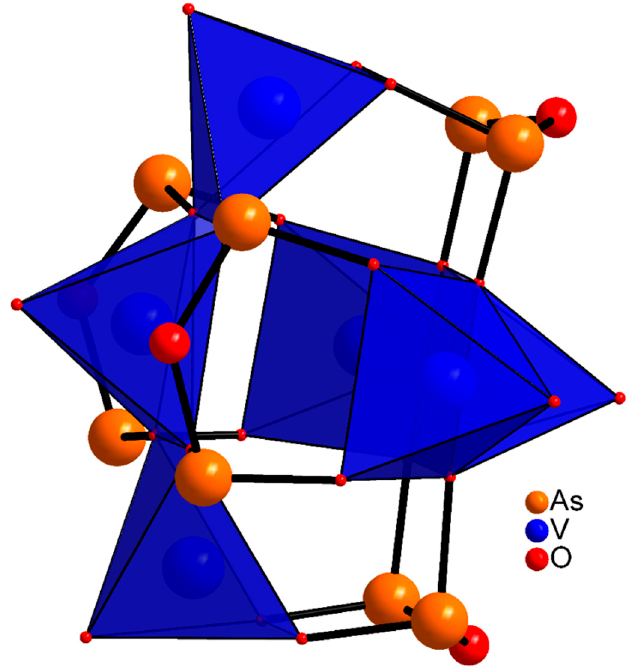
Figure 1. Polyhedral representation of the cluster anion [V 6 As 8 O 26 ] 4 − in the structures of the title compound.